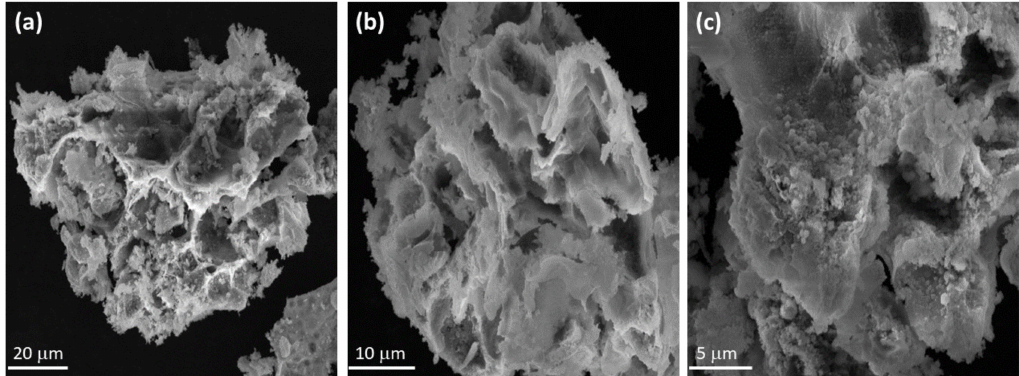
Figure 4. FE-SEM micrographs of the synthesized Mn 3 O 4 /ZnO/Eu 2 O 3 nanocomposite. ( a ) Magnification × 2800 ( b ) Magnification × 6000 and ( c ) Magnification × 12,000.